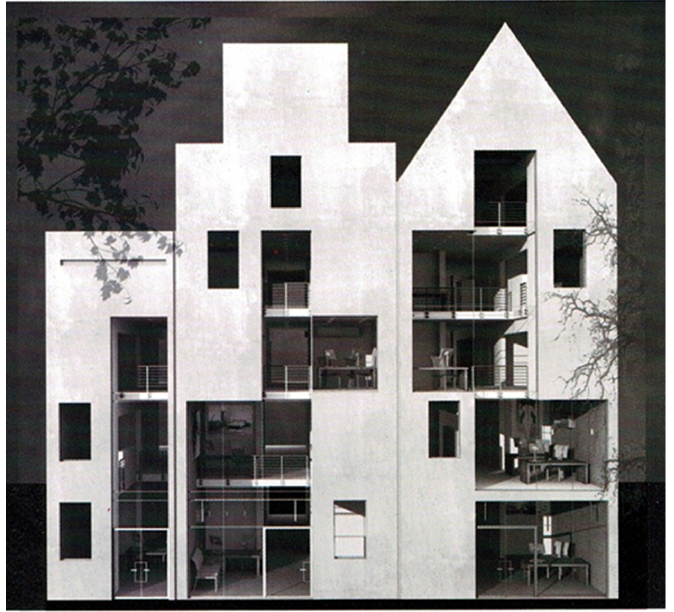
Figure 10. Awarded project of a tenement house in Gda´nsk of the 21st century. Authors: B. Domsta, J. Raniszewski, K. Lipi´nska, M. Ja´skowiec [46].